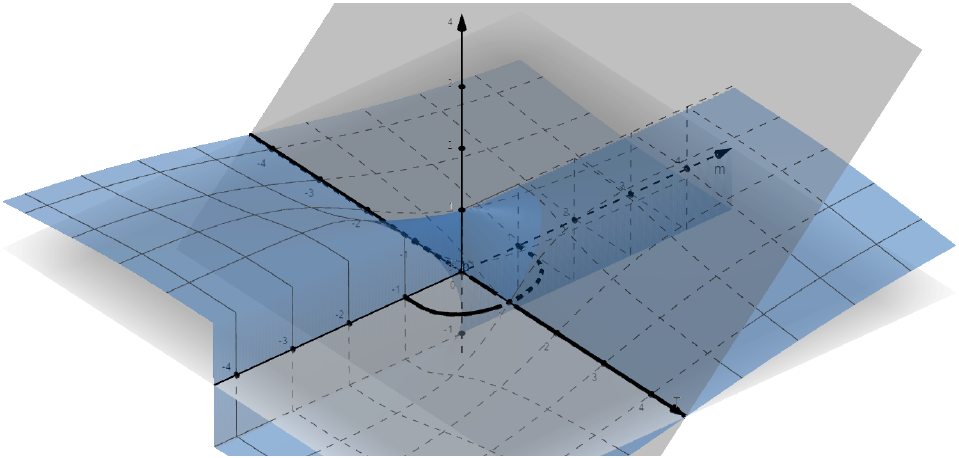
(cid:128) T (cid:138) c m . The locus T